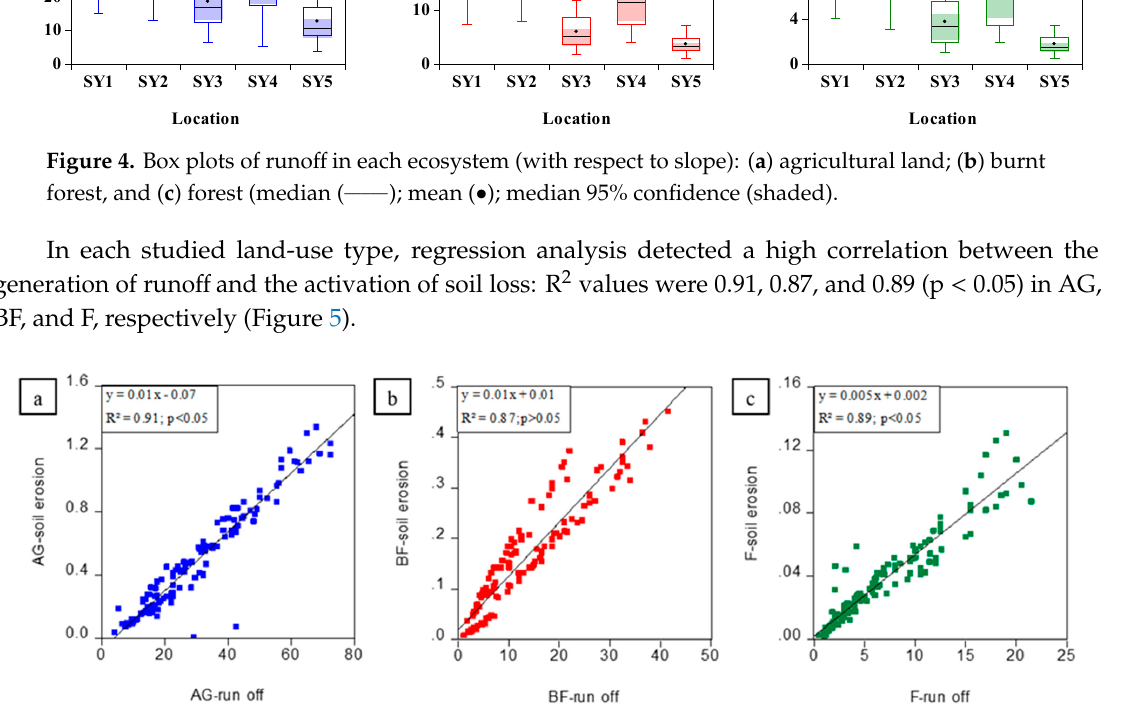
Figure 5. Correlation between soil loss (kg/m 2 ) and runoff (L/m 2 ) (regardless slope): ( a ) agricultural land, ( b ) burnt forest, and ( c ) forest.